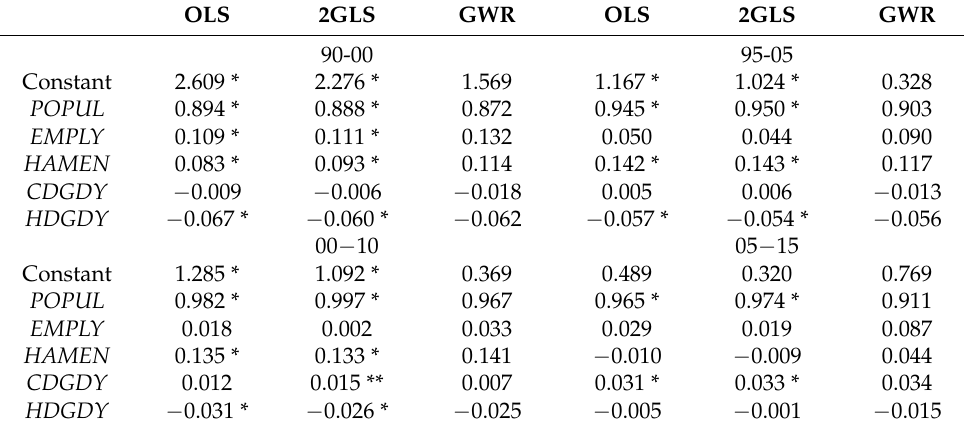
Table 1. Reduced-Form Population Estimates: 10 Year